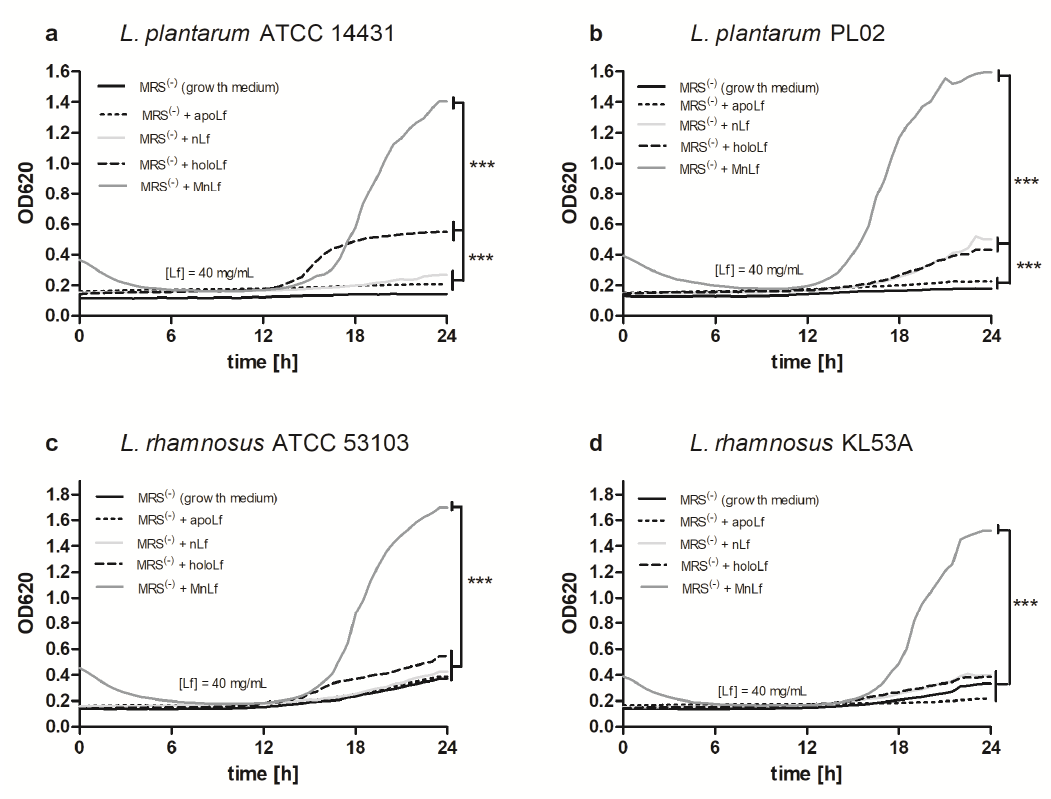
Figure 4. Semi-quantitative assessment of the growth of Lactobacillus strains upon incubation with various lactoferrin forms: Lactobacillus plantarum ATCC 14431 ( a ), L. plantarum PL02 ( b ), Lactobacillus rhamnosus ATCC 53103 ( c ), L. rhamnosus KL53A ( d ). *** p < 0.001 in one-way. MRS, Man, Rogosa and Sharpe broth.